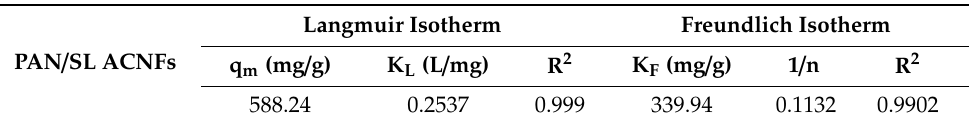
Table 4. Adsorption isotherms study of PAN / SL ACNFs. Condition: contact time = 240 min, dosage of